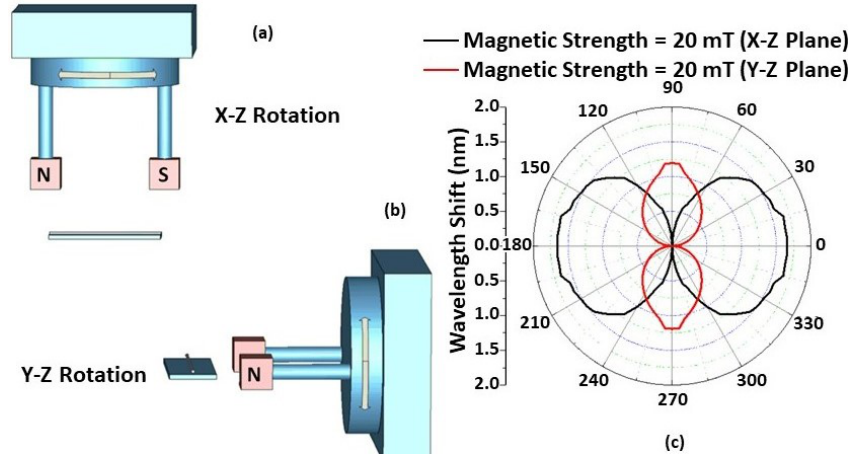
Figure 7. Schematic of the experimental setup used for measurements of the angular field dependence in ( a ) the X – Z and ( b ) the Y – Z plane; ( c ) Experimentally measured wavelength shift from λ 0 versus from 0° to 360° in the X – Z and Y – Z planes for different magnetic field strength values.